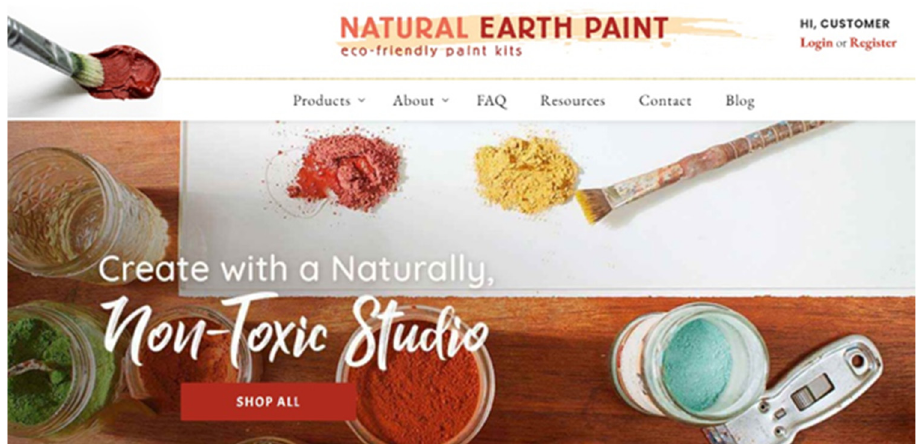
Figure 8. The all-natural paint powder the vendor selected (Source: https://naturalearthpaint.com/, accessed on 5 January 2023).